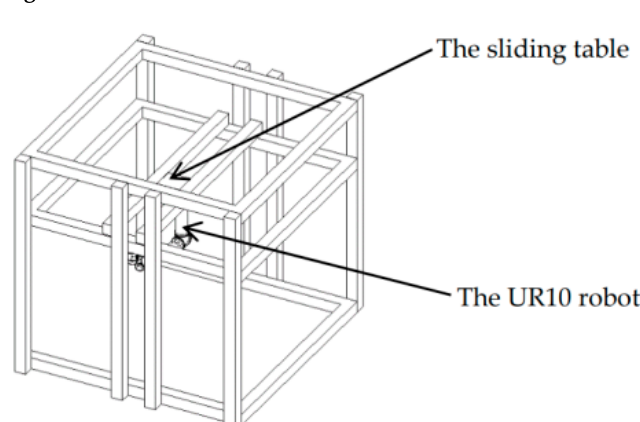
Figure 1. The UR10 robot.